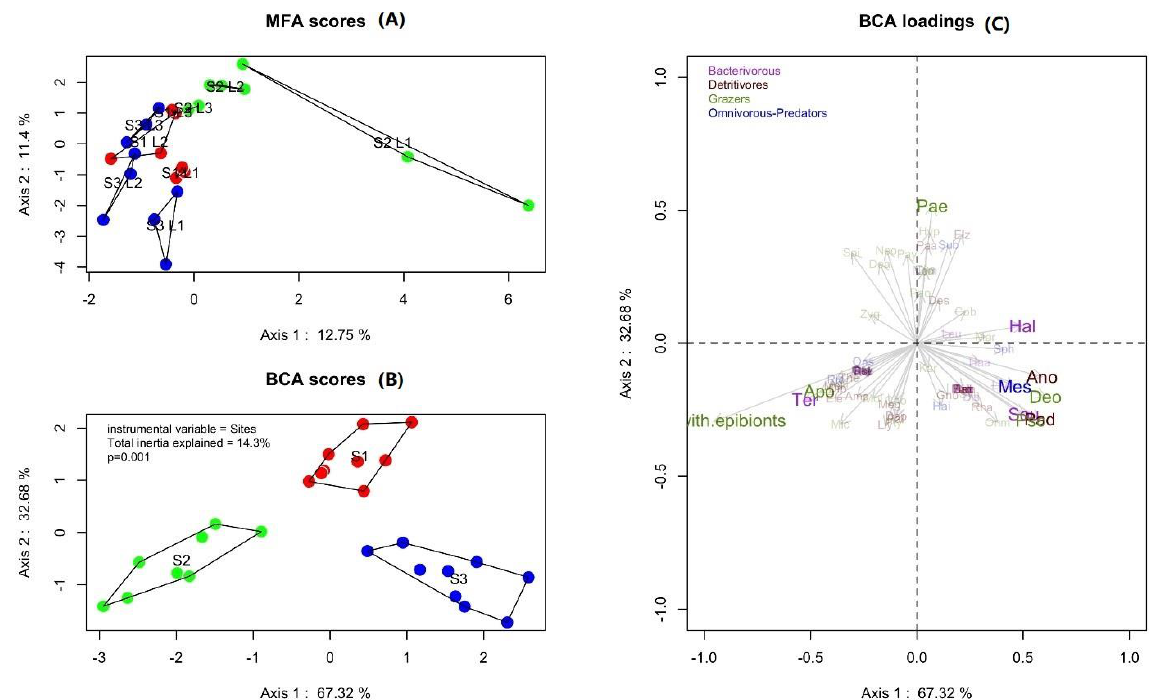
Figure 4. Multiple Factor Analysis (MFA; A ) and Between Class Analysis with a cos² threshold of 0.2 (BCA; B : stations distribution and C : variables distribution) based on relative percentages of nematodes abundances: Distribution of nematodes and their trophic groups at each station (purple: Bacterivorous nematodes; brown: Non-selective detritivores nematodes; green: Grazers nematodes; blue: Omnivorous-predators nematodes).